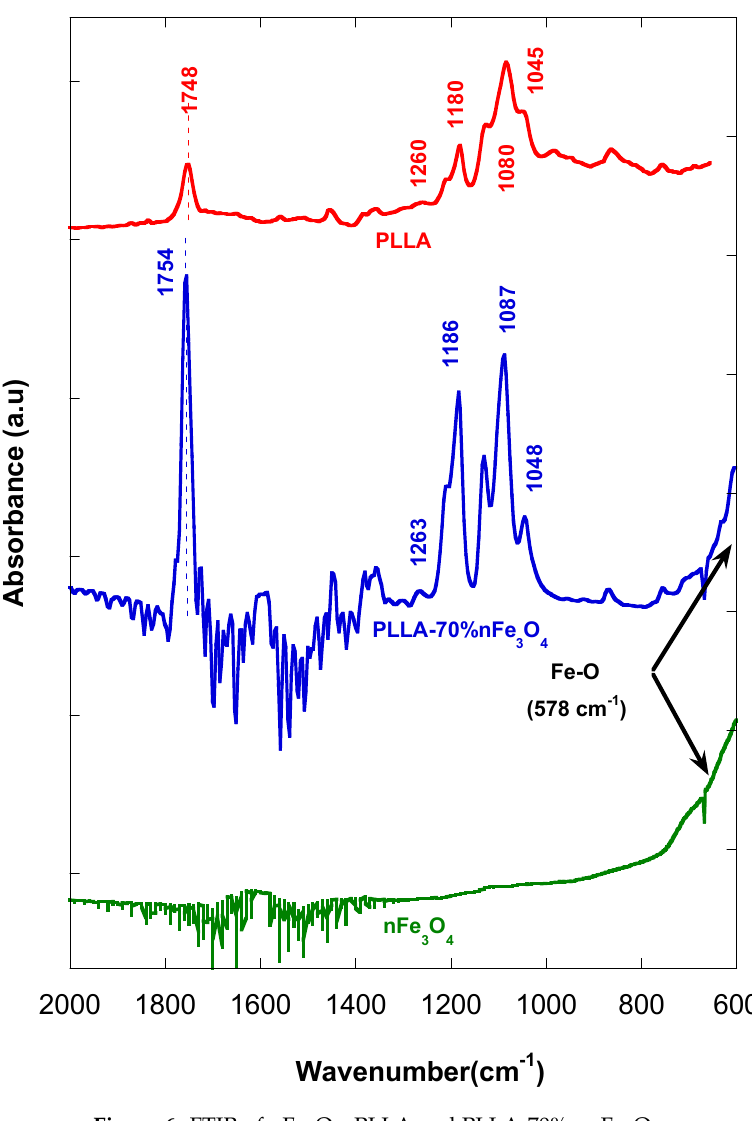
Figure 6. FTIR of nFe 3 O 4 , PLLA and PLLA-70%n nFe 3 O 4 .